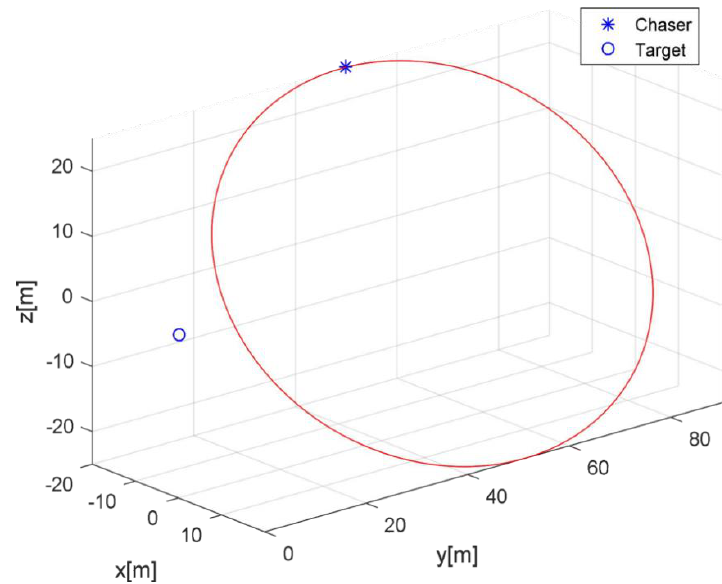
Figure 11. Simulation of the relative motion trajectory.